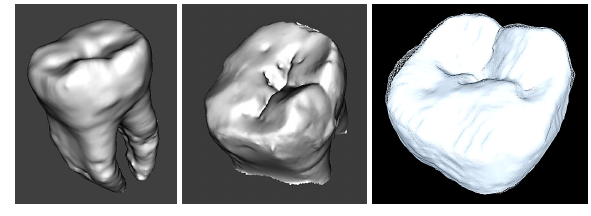
Figure 4. Segmented from CBCT, cut from intraoral scan, combined both, 4.7 molar (Early Bronze)